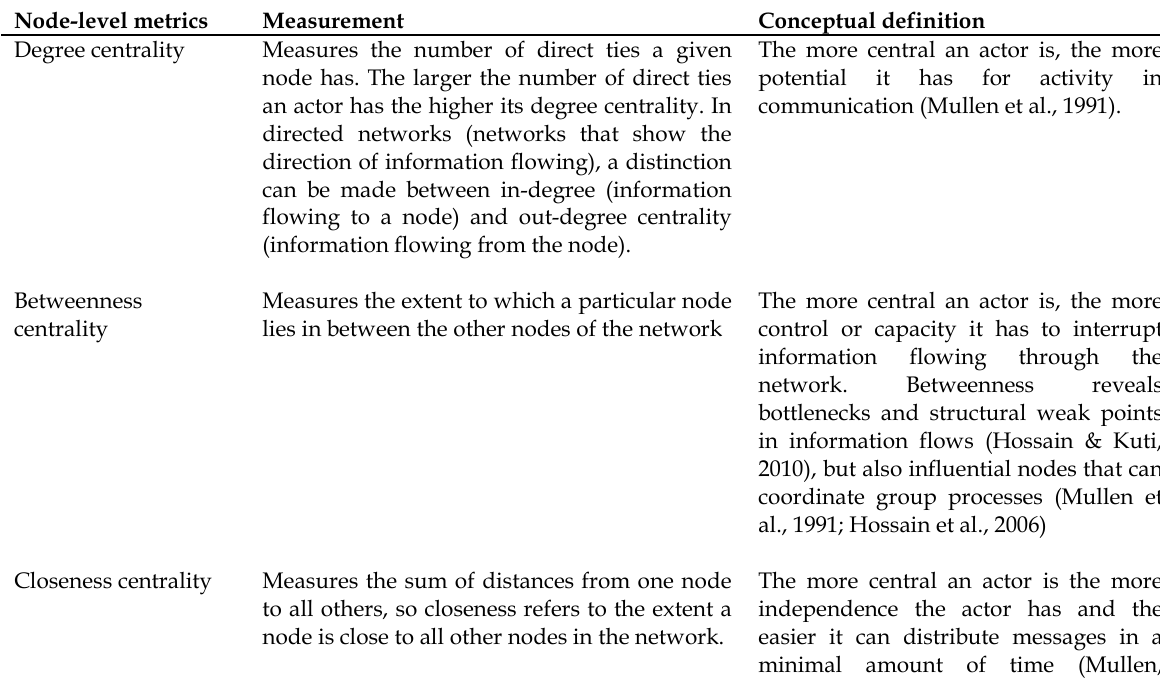
Table 2. Node-level metrics and their conceptual definition